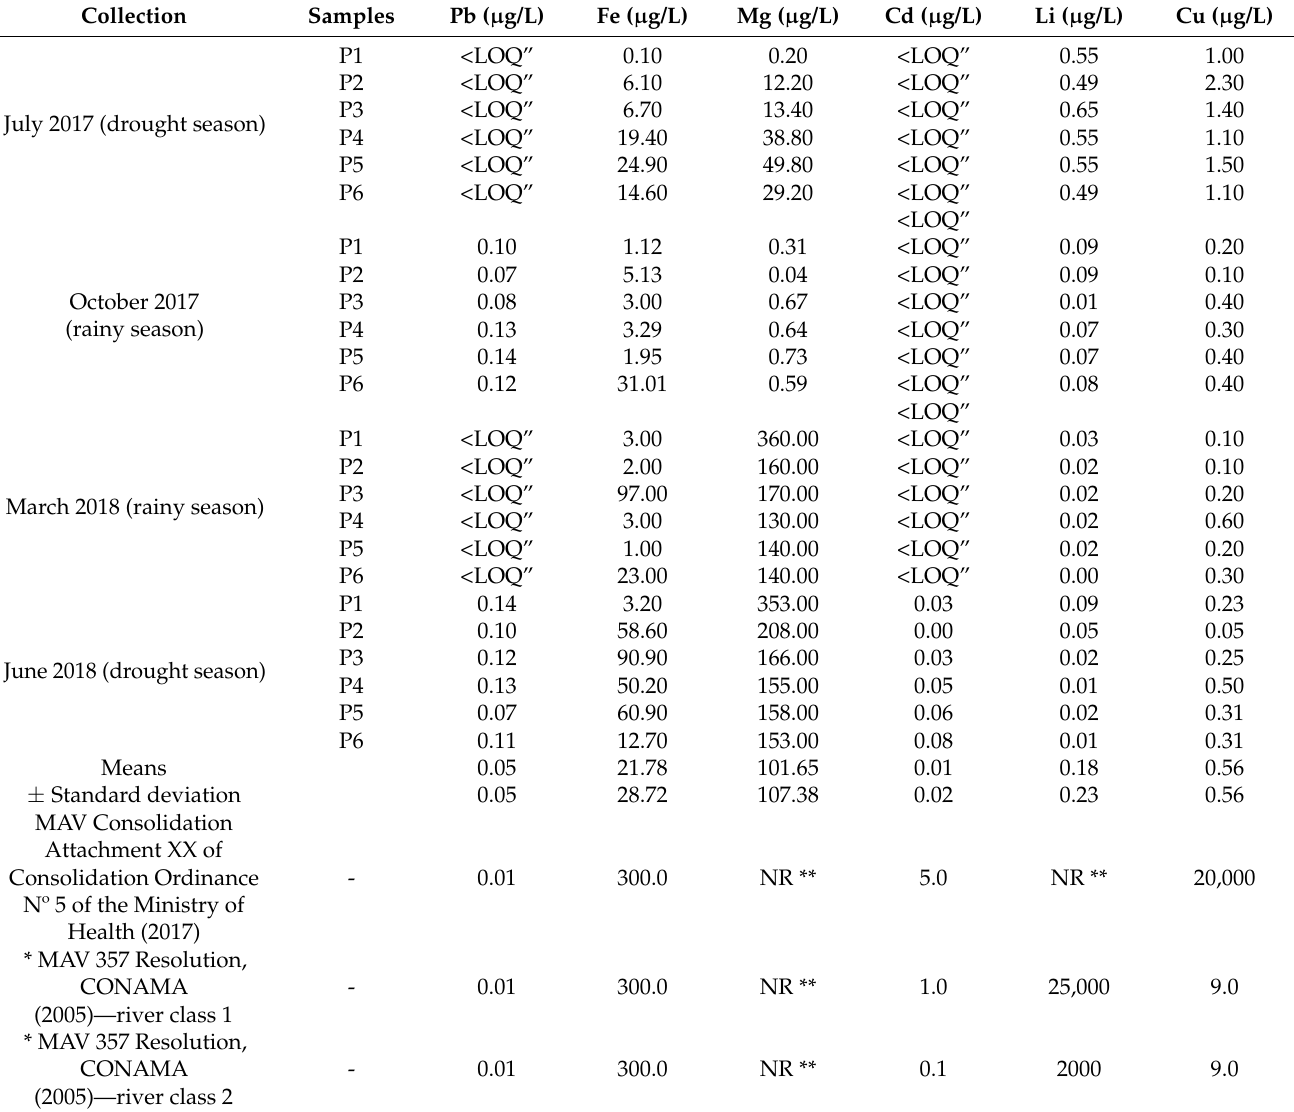
Table 4. Results of the analysis of metals present in the water of Buritis Lake and maximum allowed value according to